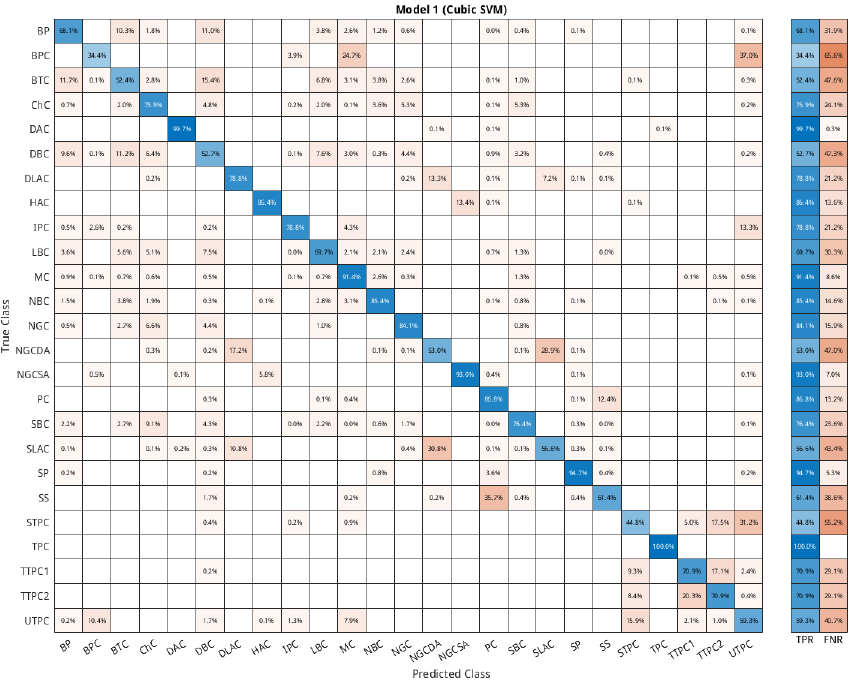
Figure A2. M-type confusion matrix. The colors represent the level of performance of the classification task per cortical layer. Blue represent strong performance level, and red represent weak performance level. The darkness of the color represents its value, being the darkest the highest values.